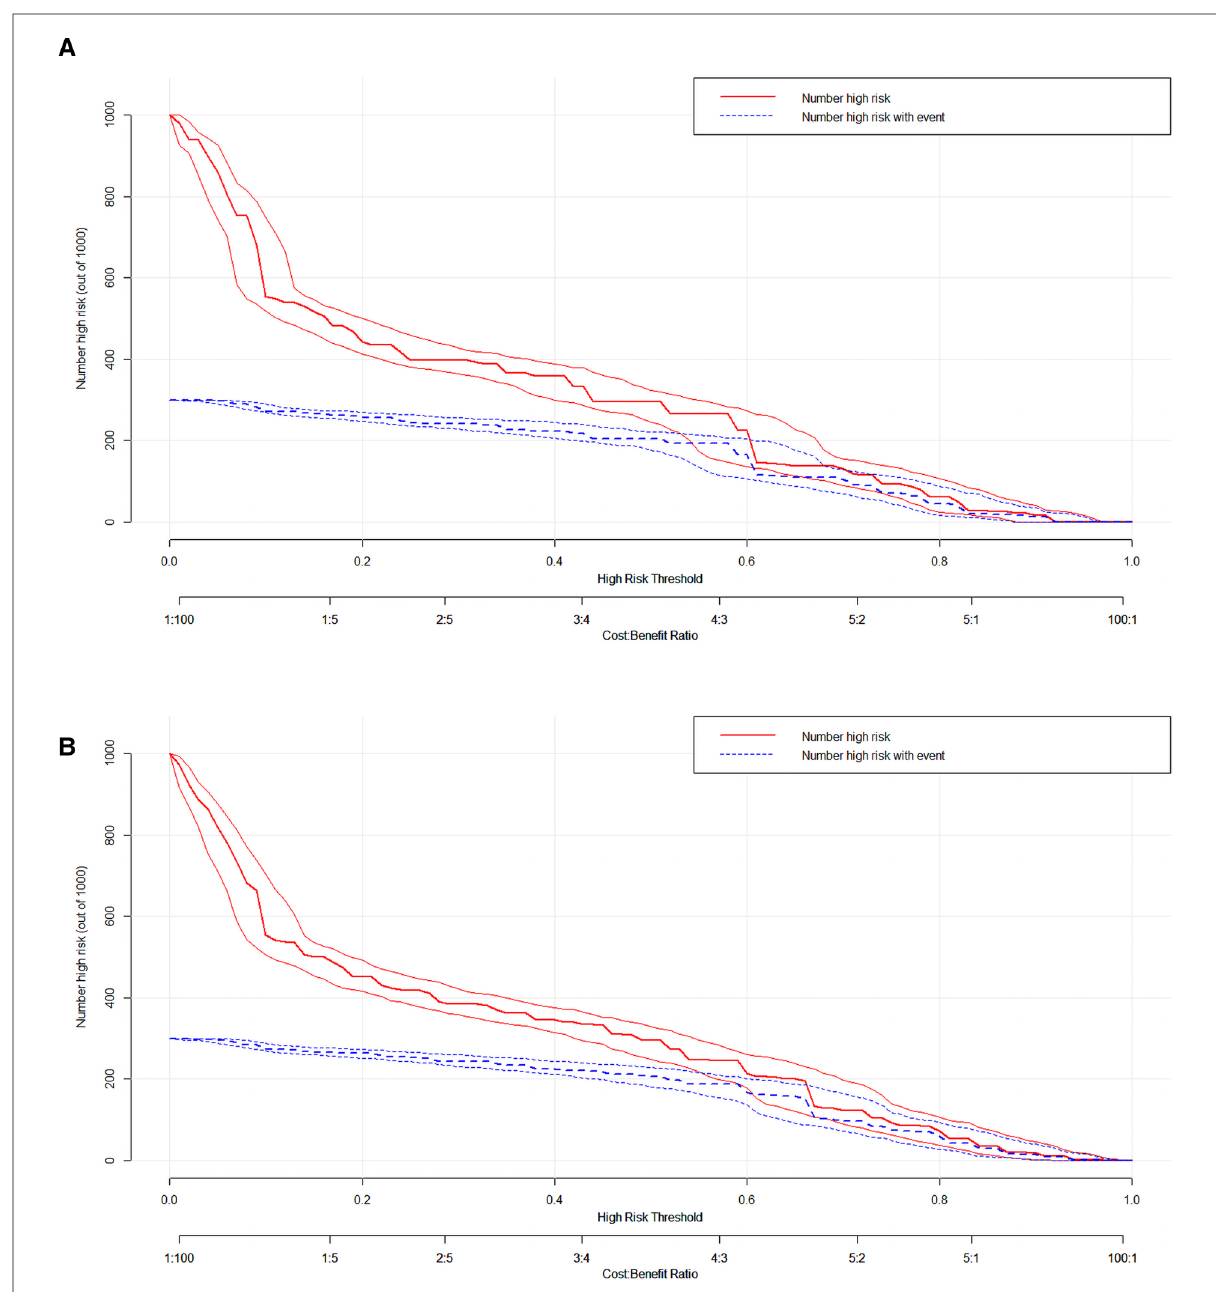
FIGURE 7 The clinical impact curve (CIC) curve for nomogram. ( A ) The total early death; ( B ) The cancer-speci fi c early